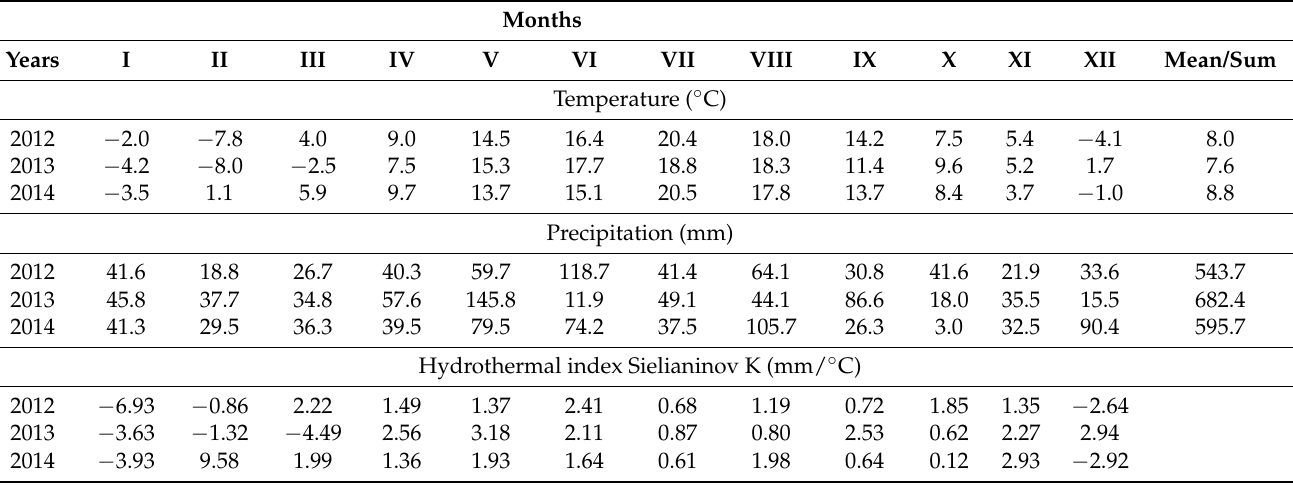
Table 2. Characteristics of hydrothermal conditions, on the basis of data provided by the Institute of Meteorology and Water Management in Warsaw, the Hydrological and Meteorological Station in Siedlce